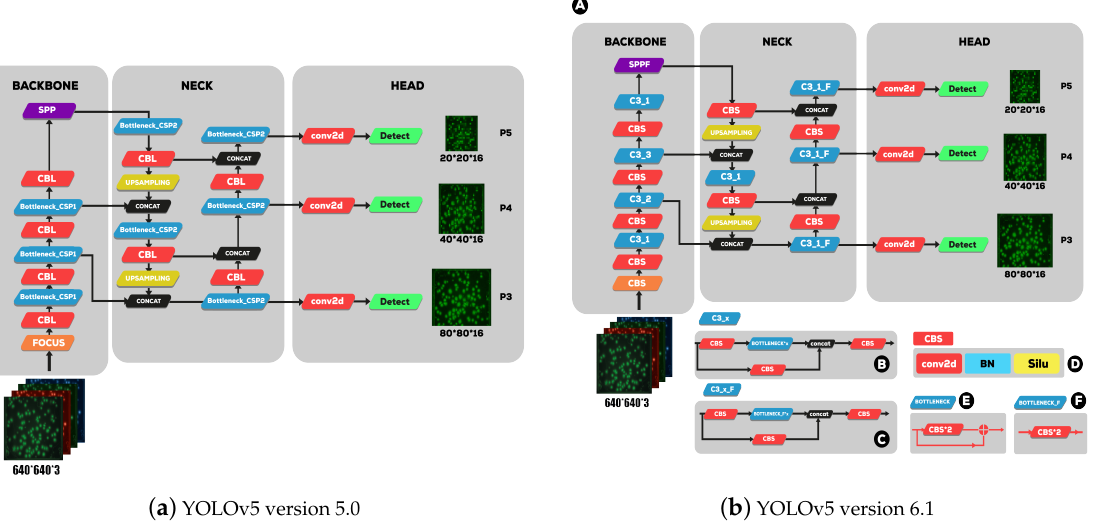
Figure 6. ( a ) YOLOv5 version 5.0 architecture, which consists of three main parts: the backbone, the neck, and the head. ( b ) YOLOv5 version 6.1 (A): the overall architecture that consists of three main parts: the backbone, the neck, and the head modules. (B,C) Two distinct types of CSP blocks (C3).